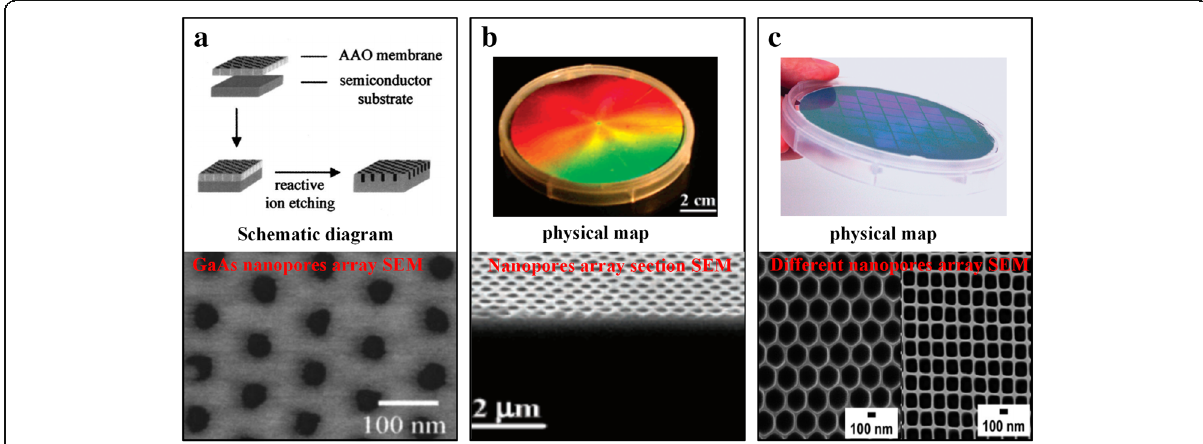
Fig. 2 Preparation of solid-state nanopore by mask etching methods. ( a ) GaAs solid-state nanopore [25], ( b ) silicon nanopore [33], and ( c ) aluminum nanopore with different shapes